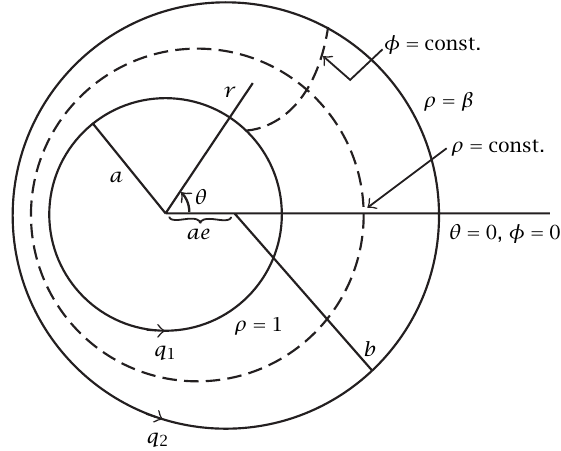
Figure 2.1 . Geometry and coordinate